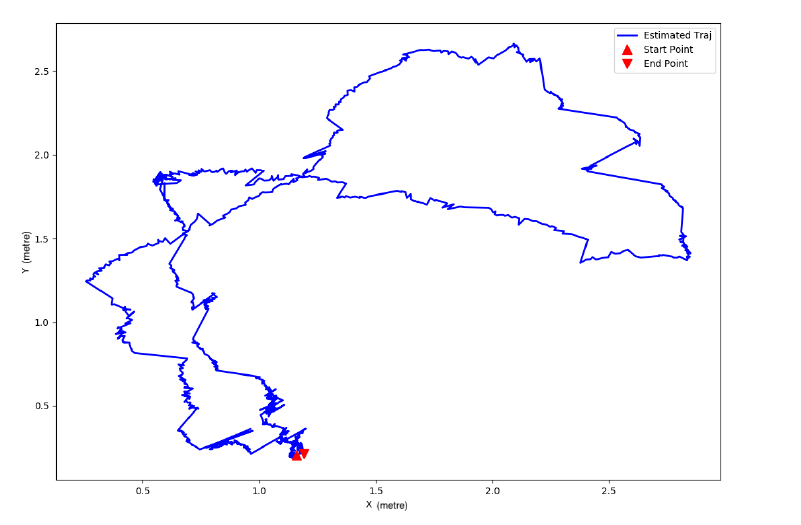
Figure 12. Closed trajectory—3rd.